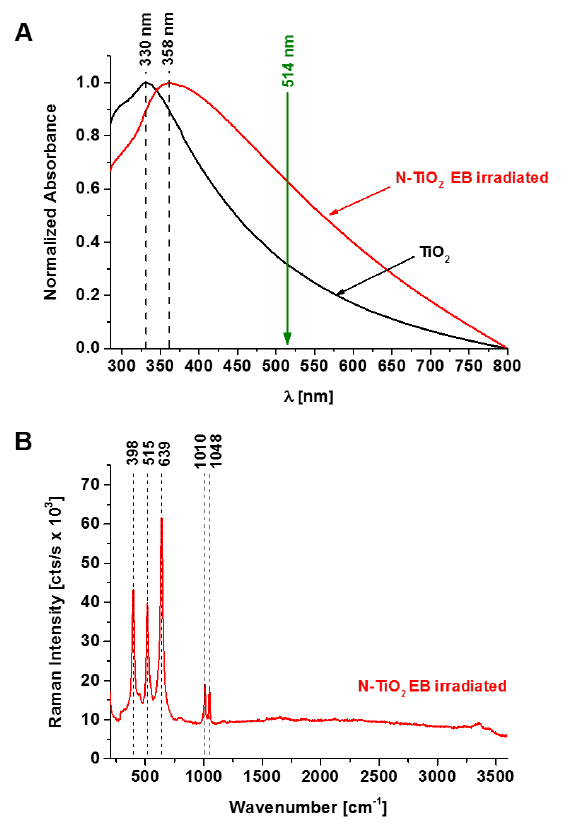
Figure 1. Electronic absorption ( A ) and Raman ( B ) spectra of N-doped TiO 2 (N:Ti = 1:1) nanoparticles electron beam-irradiated with a dose of 500 kGy.